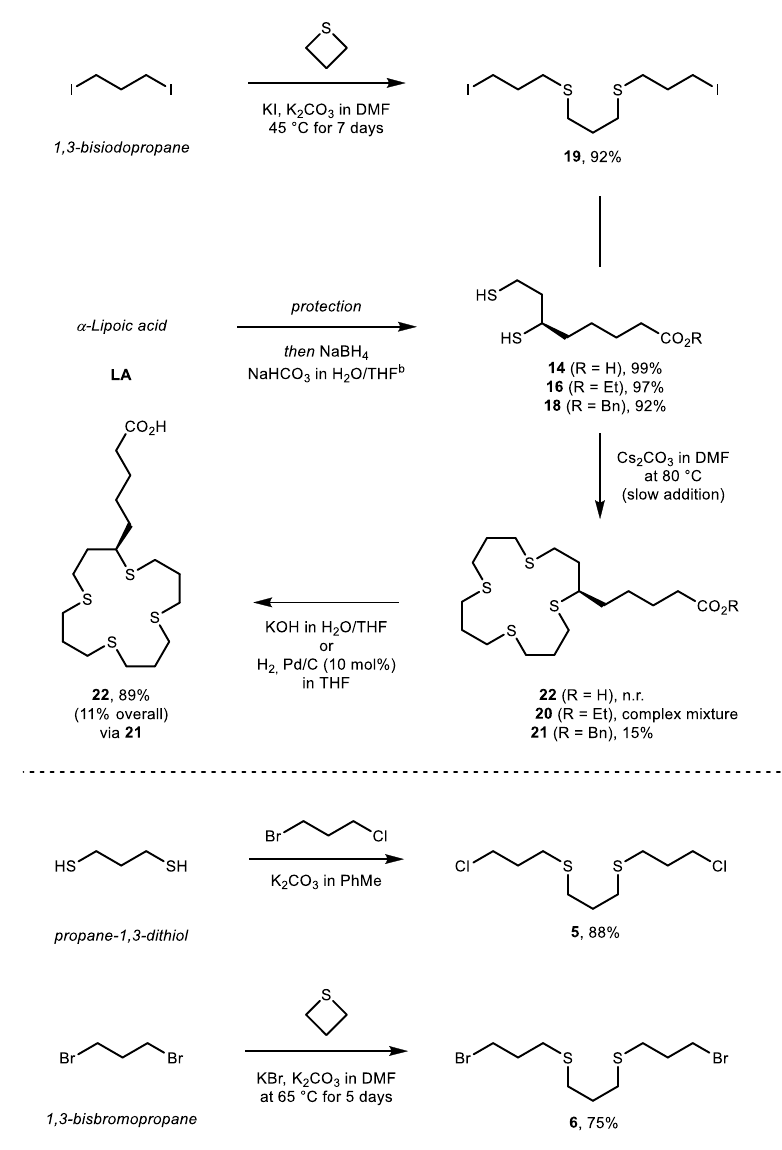
Figure 4. Alternative synthesis of bifunctional [16]aneS4 chelator.